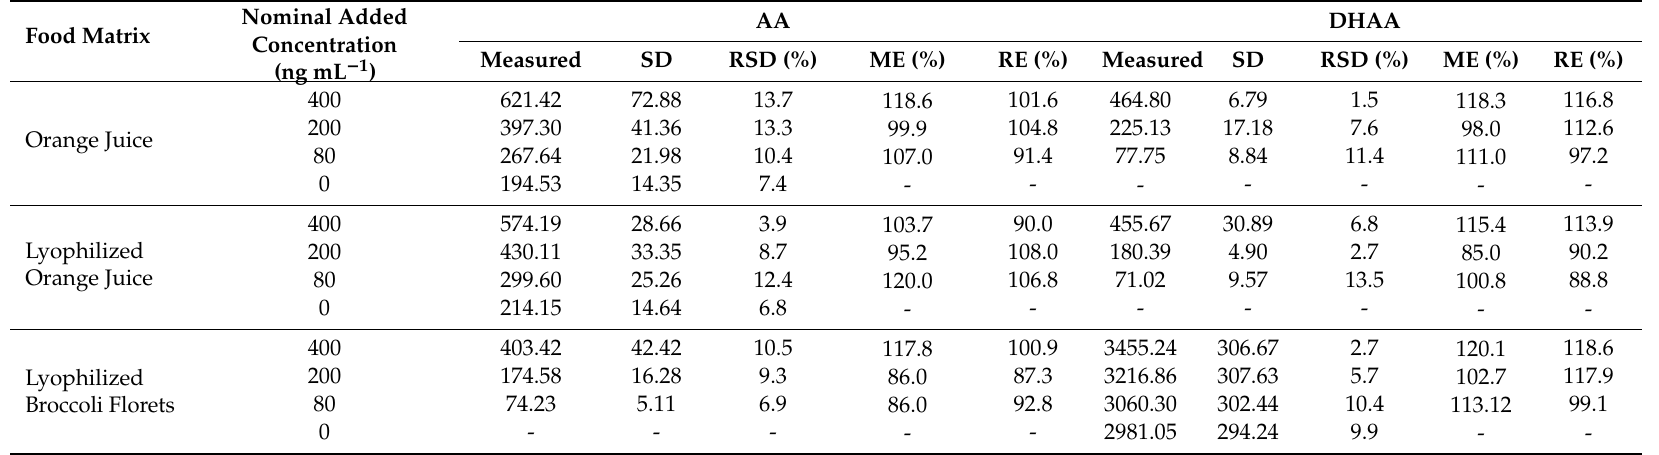
Table 4. Mean percentage of the relative standard deviations or precision (RSD%), matrix e ff ect (ME%) and absolute recoveries (RE%) of ascorbic (AA) and dehydroascorbic (DHAA)